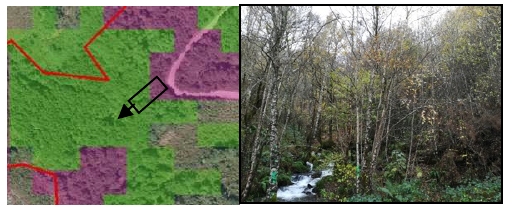
Figure 5. Model 5 classification results overlapped with the MFE. The figure shows how the MFE polygons cover non- forested areas. Red lines represent the MFE polygons. Pink- colored areas are areas classified as chestnut while green- colored areas are classified as others. PNOA Reference image (PNOA, 2016)